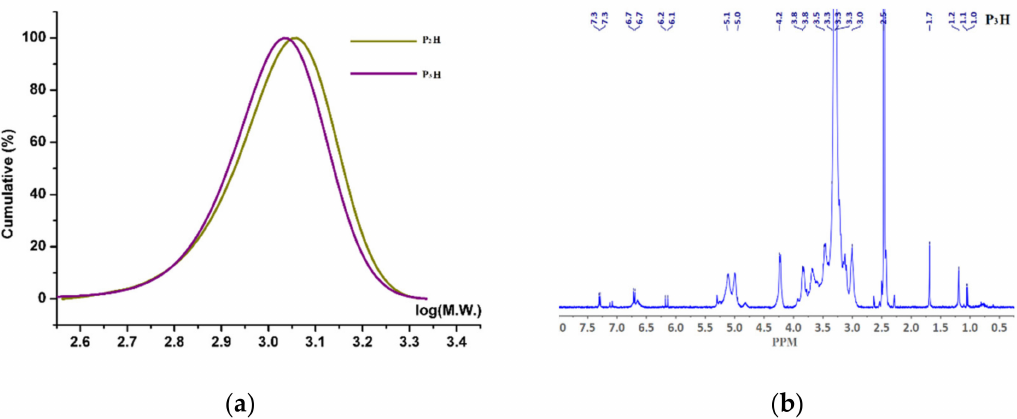
Figure 5. ( a ) Molecular weight distribution (P 2 H and P 3 H); ( b ) 1 H NMR spectrum of the selected hemicellulosic fractions (P 3